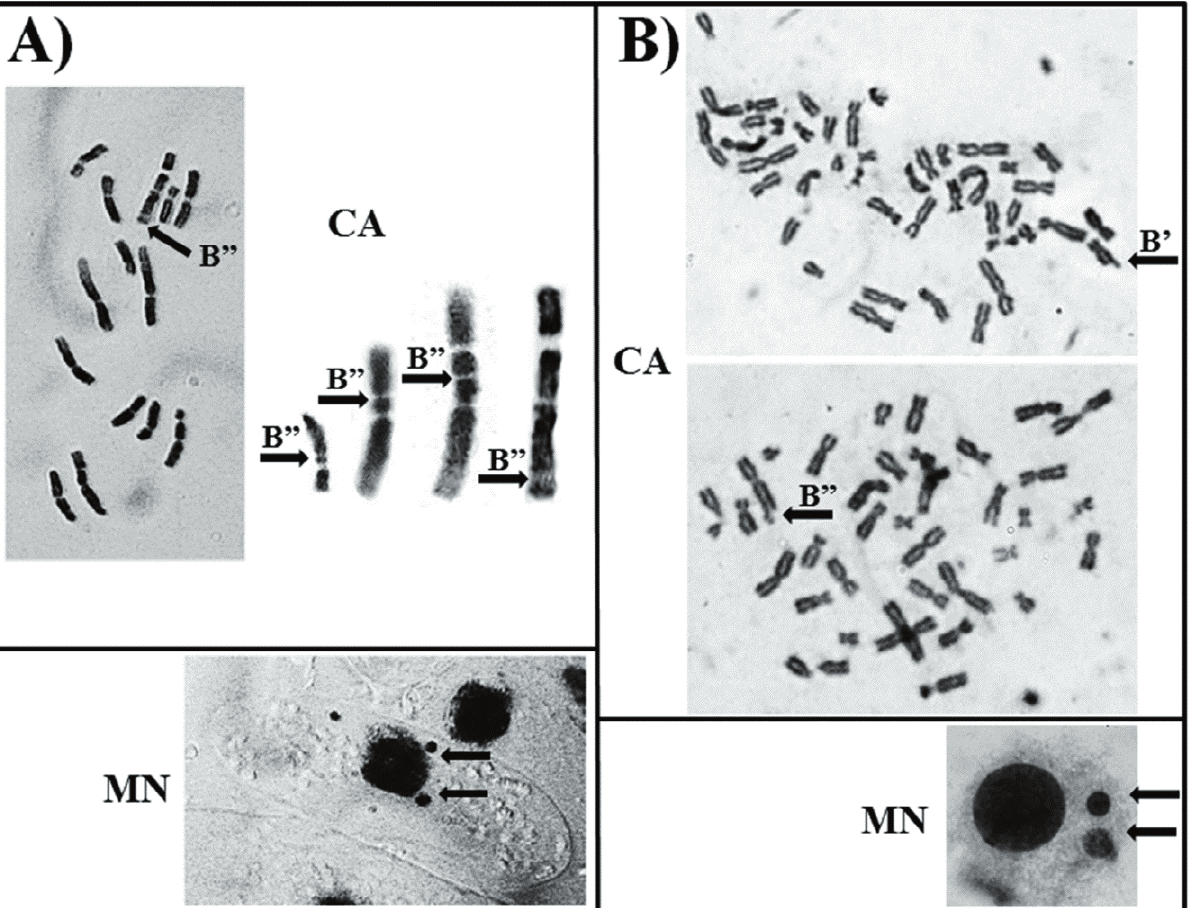
Figure 6. Types of c hromosome aberrations (CA) and micronuclei (MN) observed after treatment with Rosa alba L. essential oil in Hor- deum vulgare (A) and in human lymphocyte cultures (B).